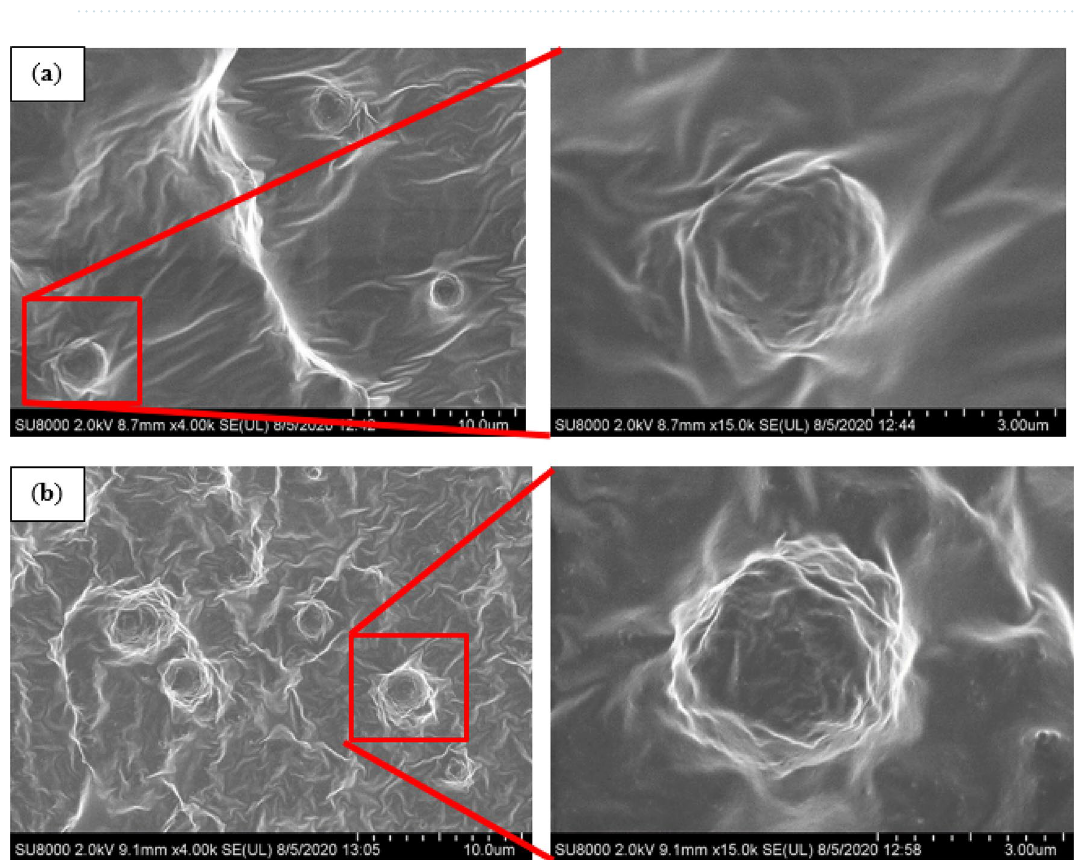
Figure 6. FESEM images of MRE containing embedded ( a ) non-corroded spherical CIPs and ( b ) corroded spherical CIPs (treated with 1.0 vol.%